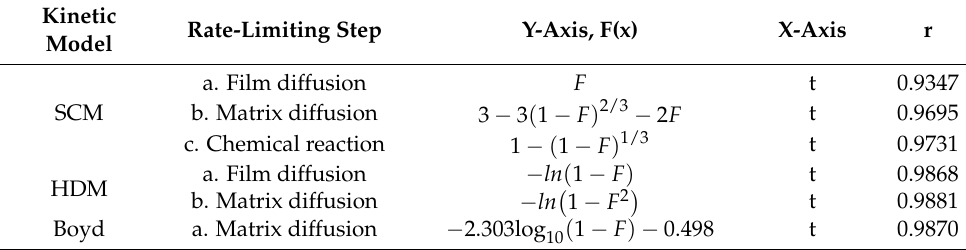
Figure 7. The dissociation process of MPH. (Arrow 1 indicates that the counter ions cross the liquid film, arrow 2 indicates the diffusion of counter ions inside the resin, 3 indicates ion exchange reaction, arrow 4 indicates the diffusion of drug ions inside the resin, arrow 5 indicates that the drug ions cross the liquid film). Table 9. The linear regression analysis for HDM, SCM, and